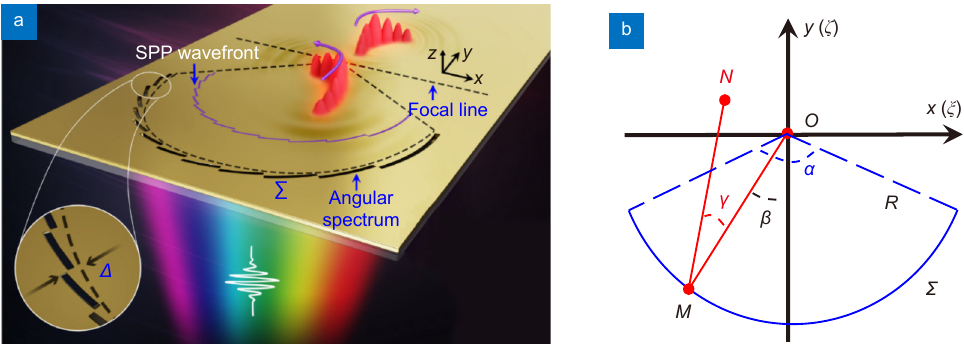
Fig. 1 | Schematics of the excitation and spatiotemporal FT modulation of SPP pulses. ( a ) Nano-slits in the angular spectrum represented by a reference arc are predesigned in the gold film (200 nm in thickness) on a glass substrate ( n =1.515). When illuminated with an angularly dis- persed femtosecond pulse, the spatially focused SPP excited by scattering from the slits is temporally modulated through dispersion, while its converging wavefront is spatially modulated by the slits through a displacement ∆ with respect to the reference arc (black dashed curve), thereby realizing both spatial and temporal FT modulation in a SPP focusing structure. ( b ) In-plane SPP focusing on metal surface. The field at any point N ( x , y ) near the focus O (0,0) can be calculated by summing the contributions from all points, e.g., M ( ξ , ζ ) on a convergent SPP wavefront. γ de- notes the angle of inclination of the distance with respect to the normal of the arc ∑ ; β denotes the angle between MO and the y